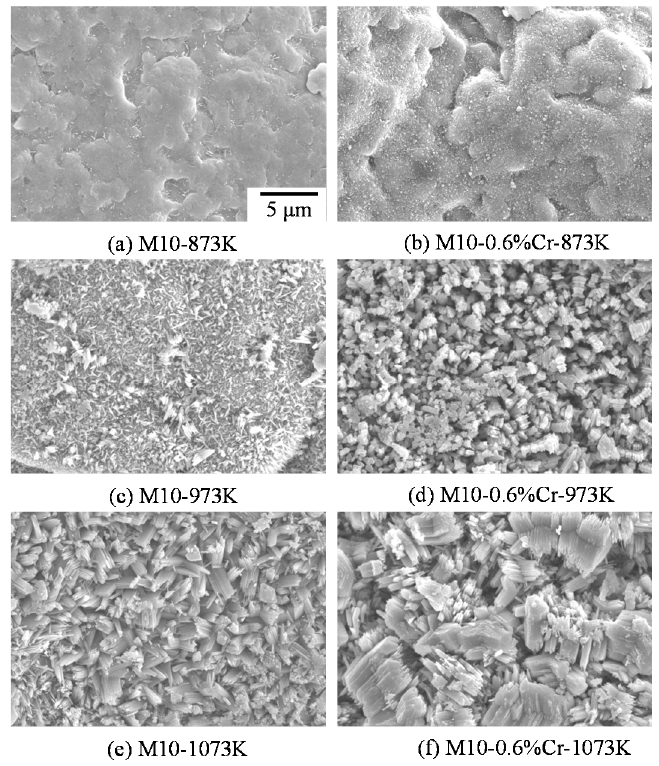
Figure 51. SEM images of surfaces of M10- x Cr- y K